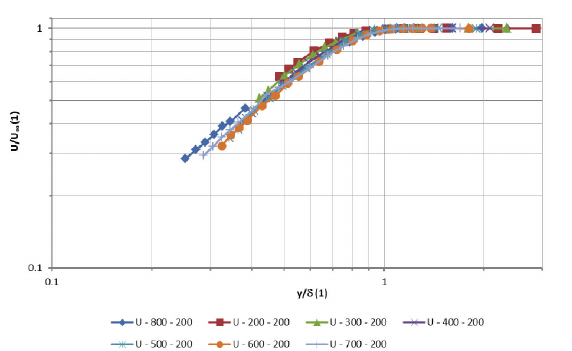
Fig. 9 Dimensionless velocity profiles U/U =f( y / δ ),